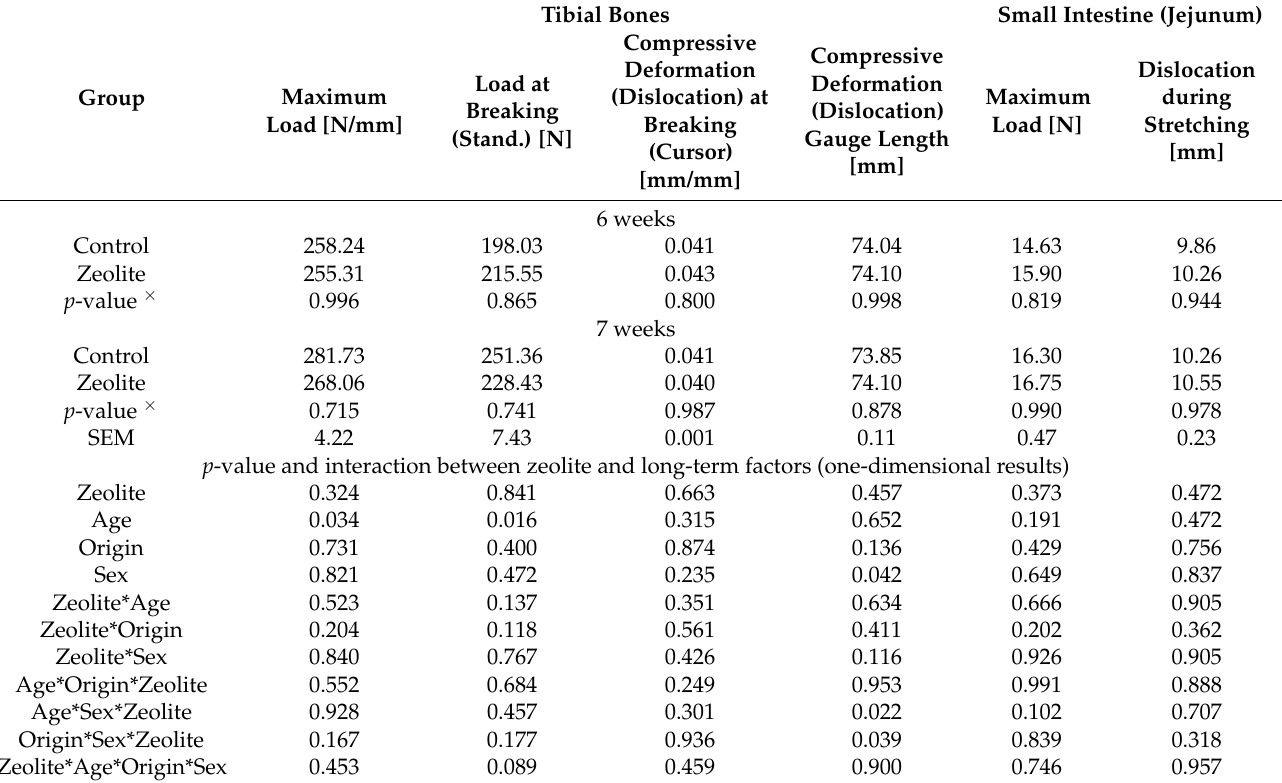
Table 8. Bones’ breaking strength and jejunum tensile strength of broiler